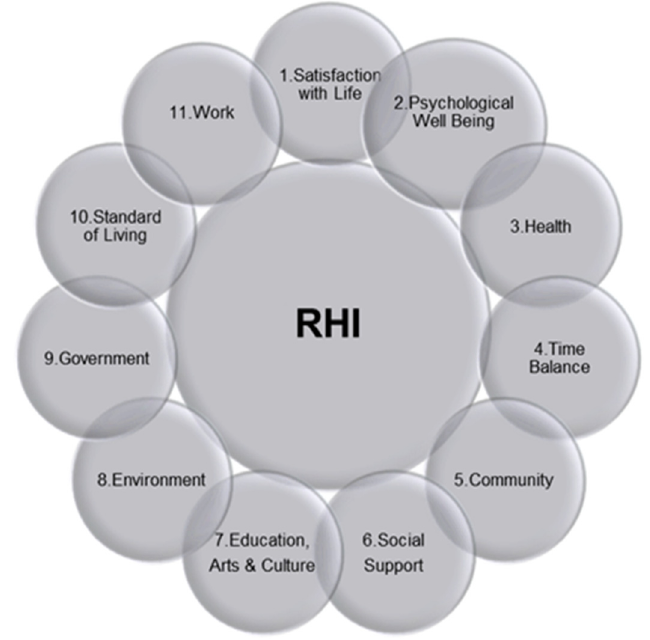
Figure 1. Domains of RHI. Compiled by the researchers.